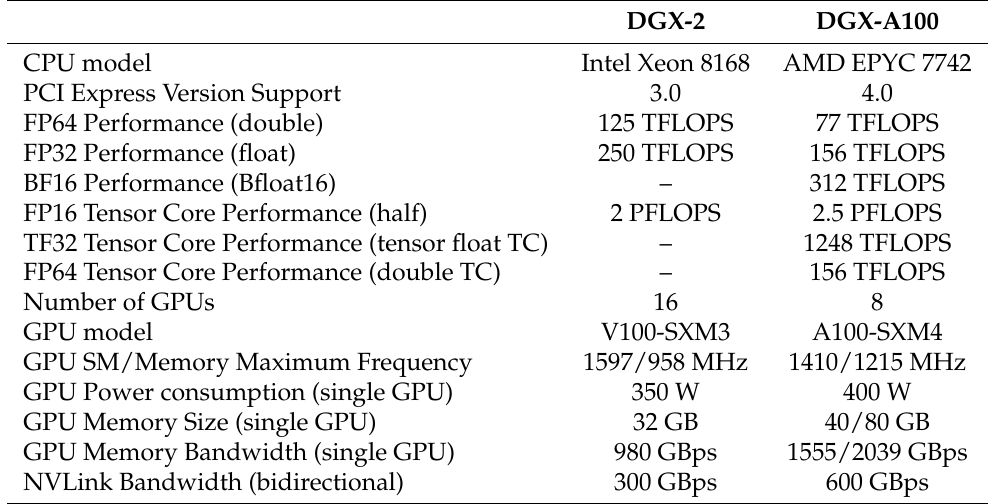
Table 1. Parameters of both DGX servers. Data are collected from Nvidia Profiler and References